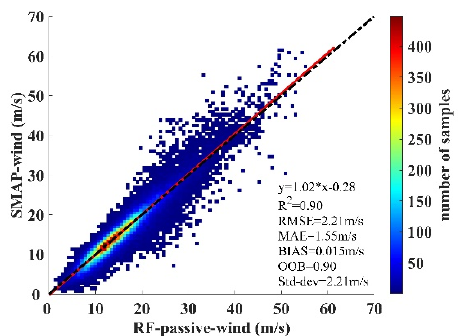
Figure 11. Haiyang-2B wind speed versus SMAP wind speed.